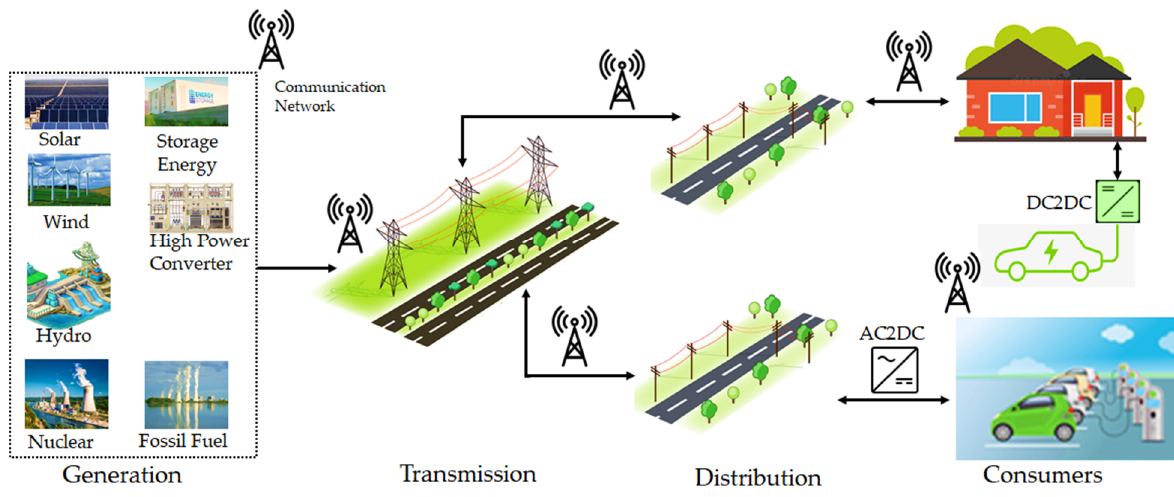
Figure 3. V2G and G2V power flow and communication system in smart grid.